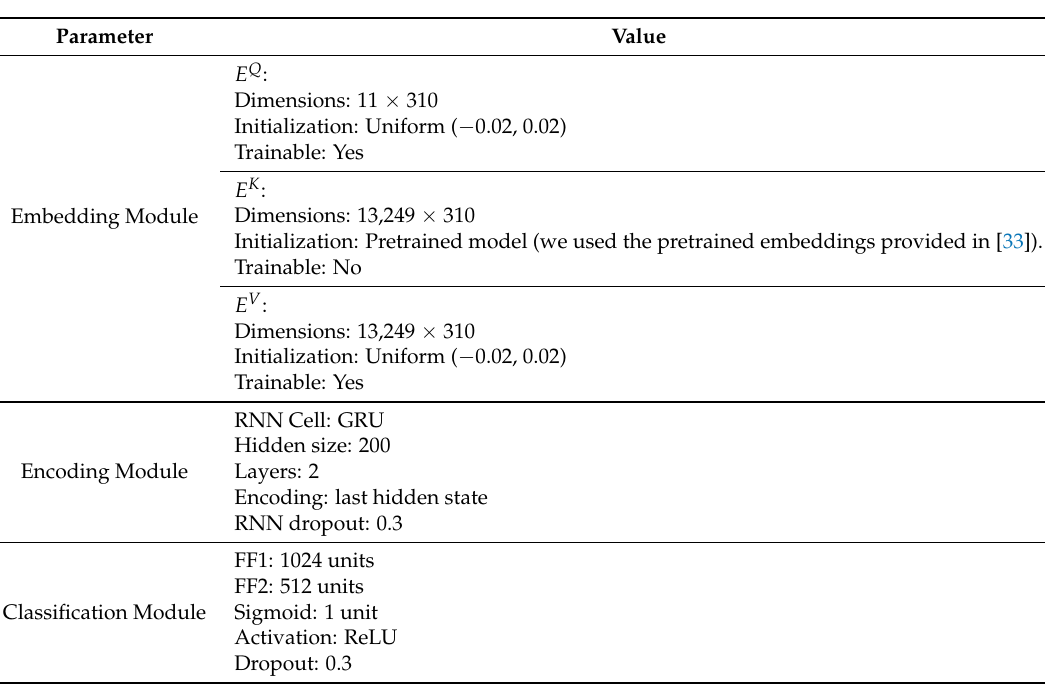
Table 1. Hyperparameters of our